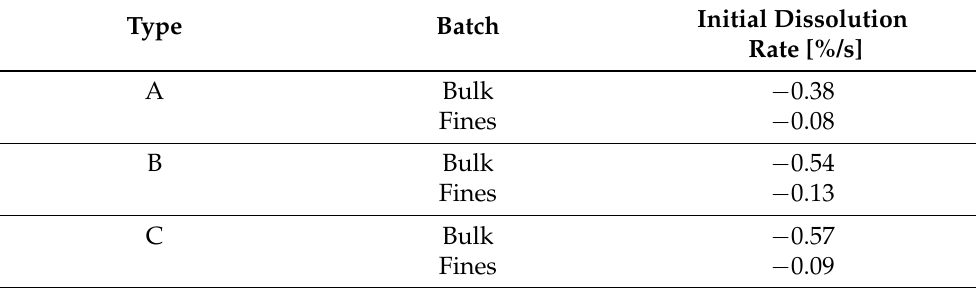
Table 5. Initial rate of surface dissolving in cm 2 s − 1 at steepest part, set relative to the measured area of raft a t = 0 s.